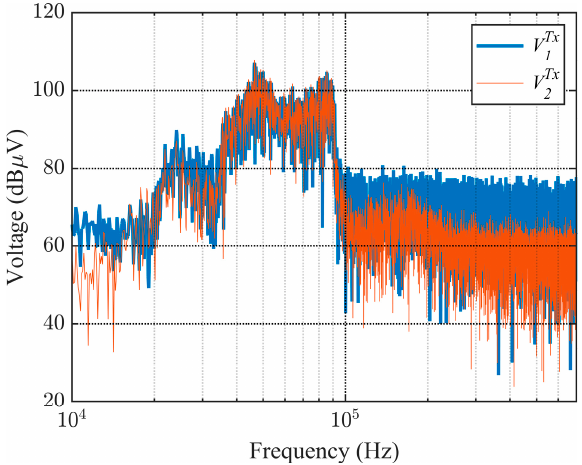
Figure 16. Equivalent voltage sources used to represent the PLC Tx modem.